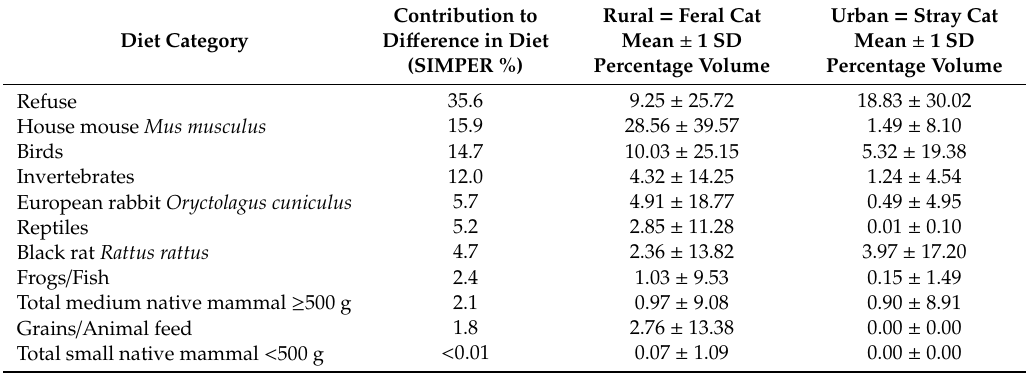
Figure 2. Estimated bite force (note Log-transformed axis) of cats ( Felis catus ) from southwest Western Australia shown by ( a ) sex (left-hand panel; males = red triangles n = 160, females = grey circles n = 108) or ( b ) source location (right-hand panel; rural = green circles and urban = blue triangles). Estimated bite force shown against age ( c,d ) and cat body mass ( e,f ). Table 3. Similarity percentage (SIMPER) analysis comparing the diets of n = 256 rural (feral) and n = 102 urban (stray) cats ( Felis catus ) collected across southwest Western